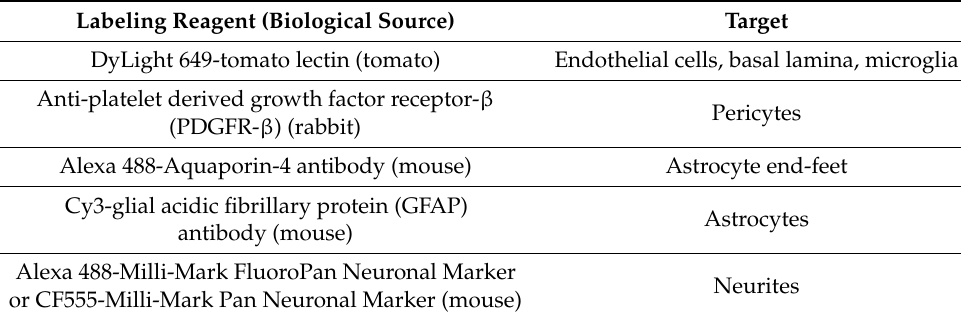
Table 1. Labeling reagents used and their cellular targets. Labeling Reagent (Biological